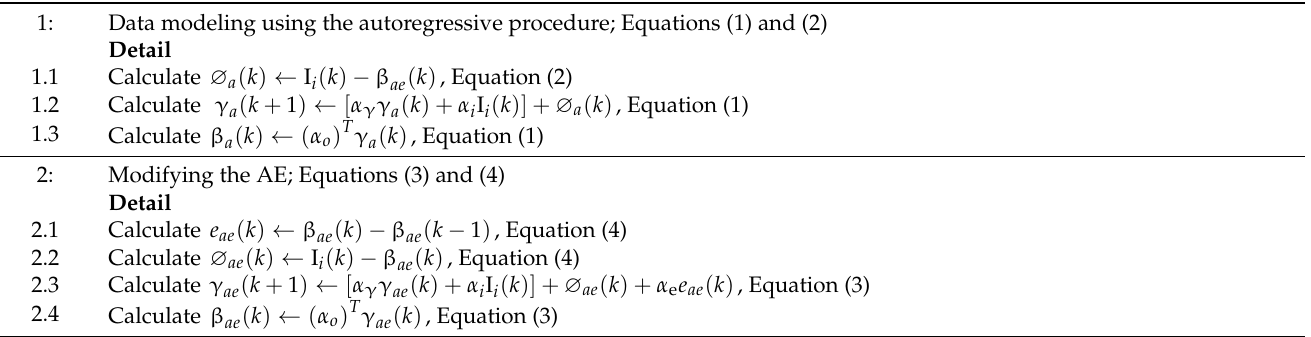
Table 2. Proposed data modeling using the combination of AE with the Laguerre filter and SVR